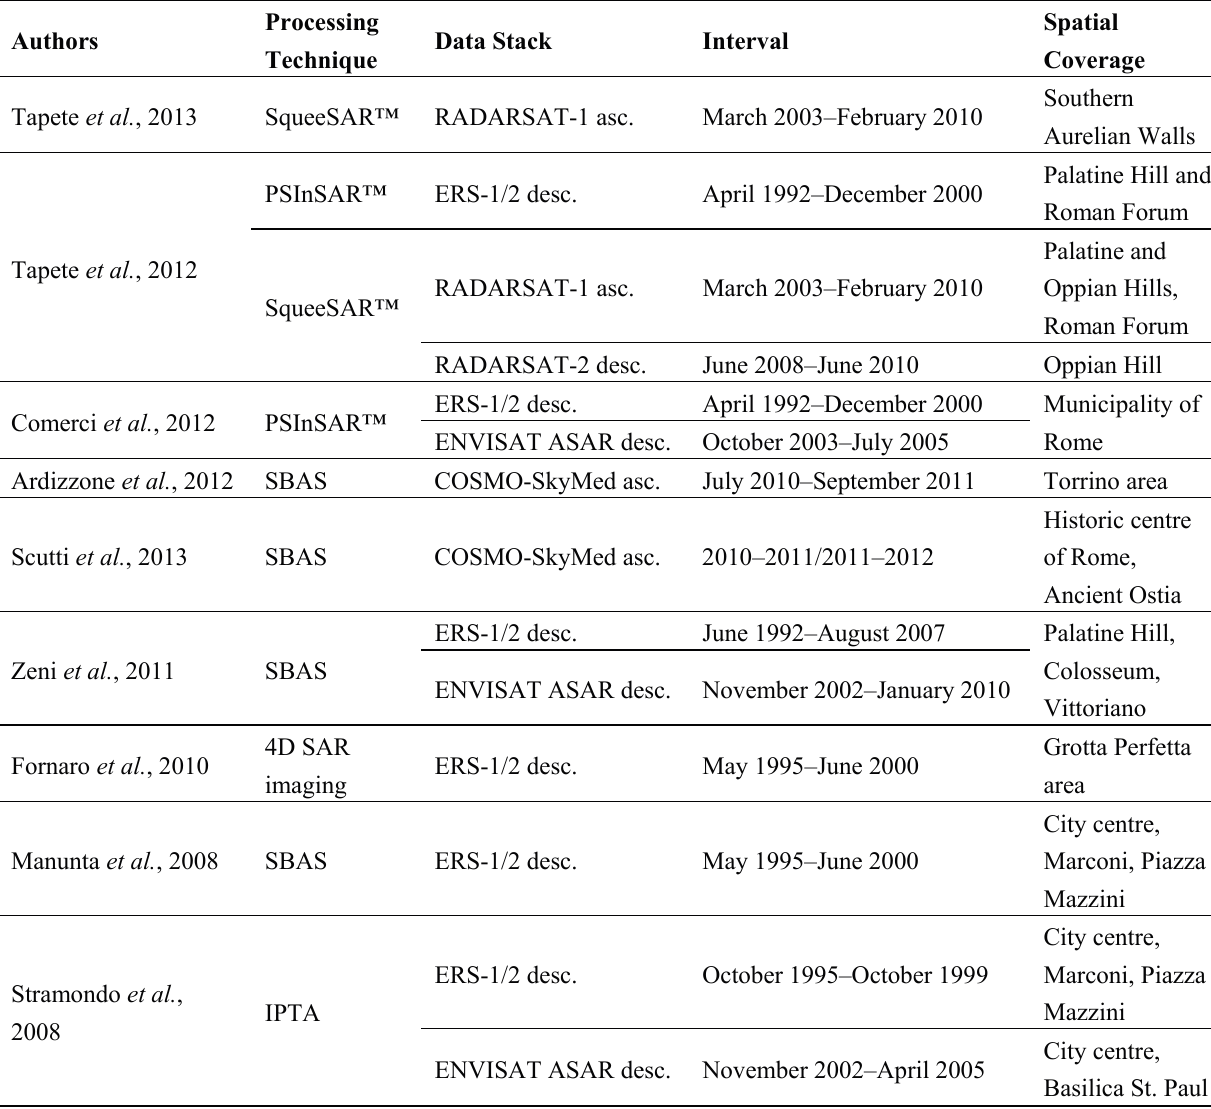
Table 2. Publications dealing with InSAR processing and radar interpretation over the historic centre and residential areas of Rome, Italy, which are recalled throughout the paper for comparative evaluation. SBAS, Small BAseline Subset; IPTA, Interferometric Point Target Analysis; asc., ascending orbit; desc., descending